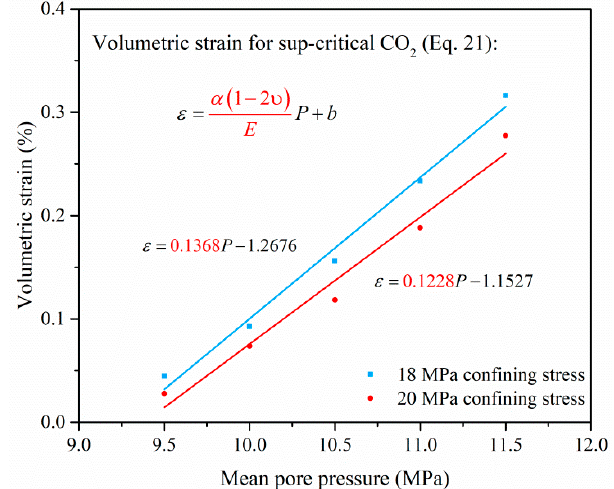
Figure 12. Variation of the volumetric strain versus the mean pore pressure (the mean of upstream and downstream pressures) of super critical CO 2 at 18 and 20 MPa confining pressures.